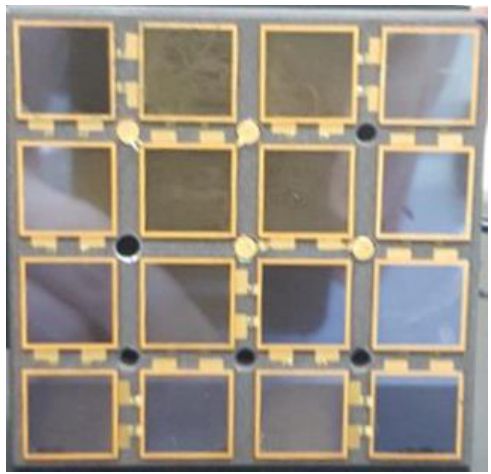
Figure 2. Laser photovoltaic (PV) module with 16 cells connected in series.